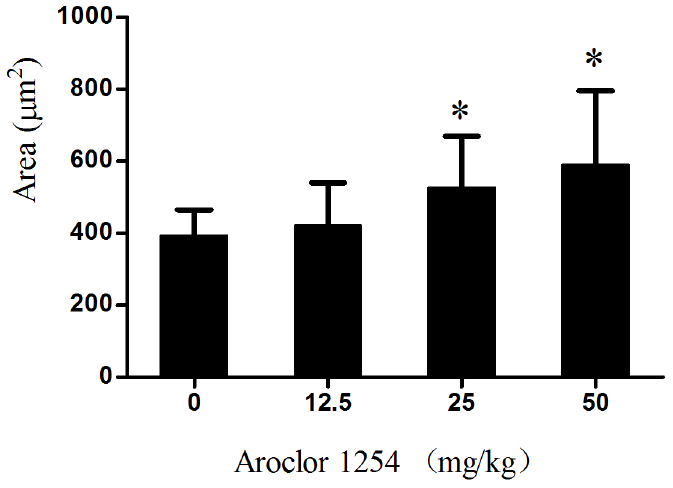
Figure 2. Effects of Aroclor 1254 administration on the spindle area of invivo matured oocytes ( n =18). *Compare to control group, P , 0.05; D Compare to 12.5 mg/kg Aroclor 1254 group, P , 0.05.